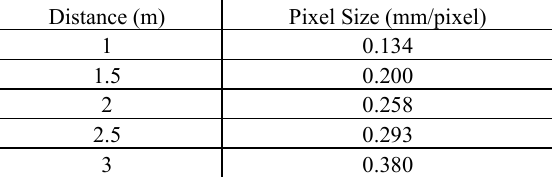
The absolute error rate is displayed in Table 7.